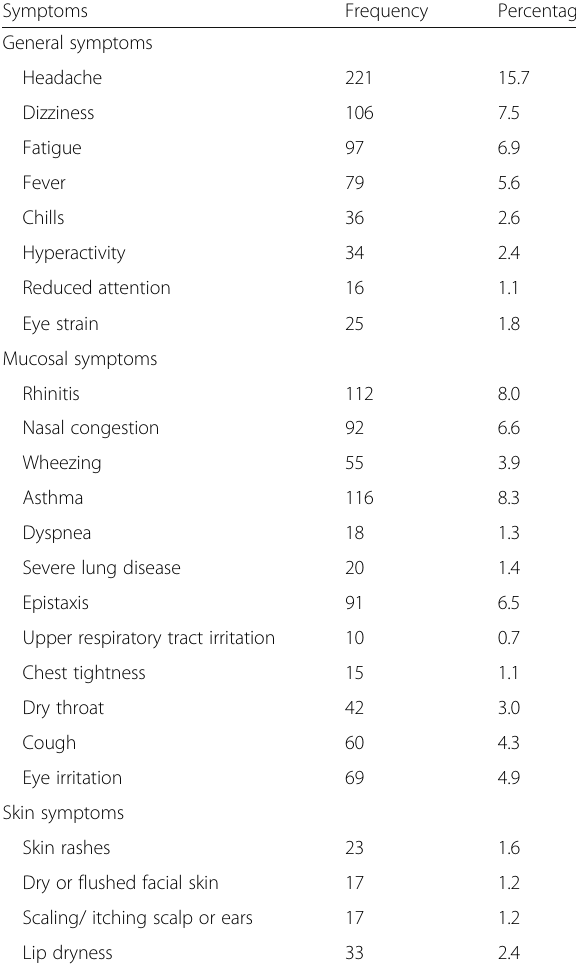
Table 5 Factors associated with sick building syndromes among the population of Gondar town, northwest